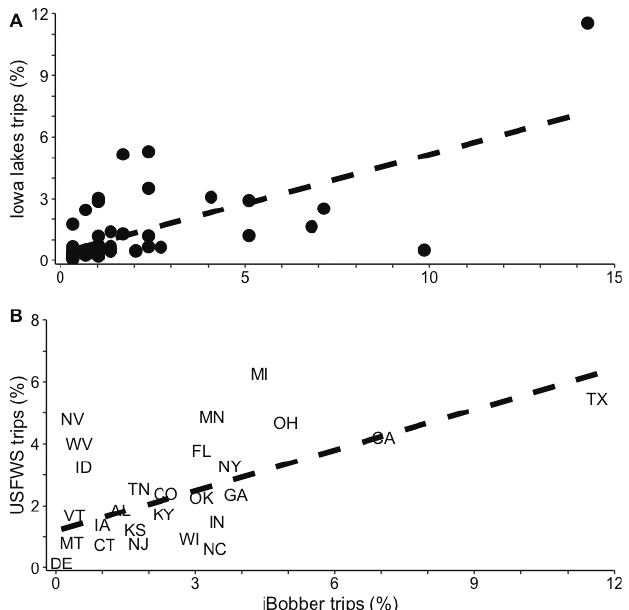
Figure 4. A Total Iowa iBobber user activity by lake (%) versus the total visits by lake (%) as quantified by an Iowa State University state-wide survey ( p = 7.5 x 10 -8 , R 2 = 0.425) (Evans et al. 2011) B total iBob- ber user activity by state (%) versus total angling activity by state (%) as quantified by the 2011 USFWS National Survey (U.S. Department of the Interior 2014).